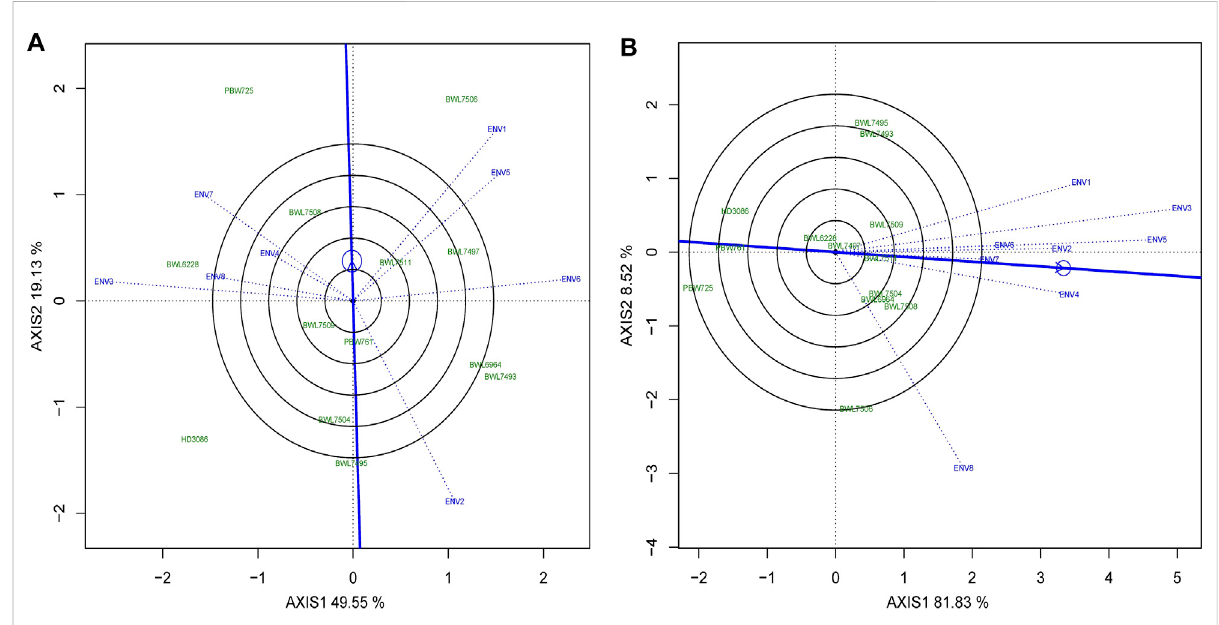
FIGURE 7 The “ Discrimitiveness vs. Representativeness ” model of biplot evaluate the genotypes anianst the ideal genotypes conferring genotype interactionandGEIfor13breadwheatgenotypesacrossfourlocations(Ludhiana,Ballowal,Patiala,andBathinda)ofPunjabintwoconsecutiveyears (2019 – 20, and 2020 – 21) for (A) yield (kg/plot) and (B) GPC (%). (ENV1, and ENV5 = Ludhiana; ENV2, and ENV6 = Ballowal;ENV3, and ENV7 = Patiala; ENV4, and ENV8 =